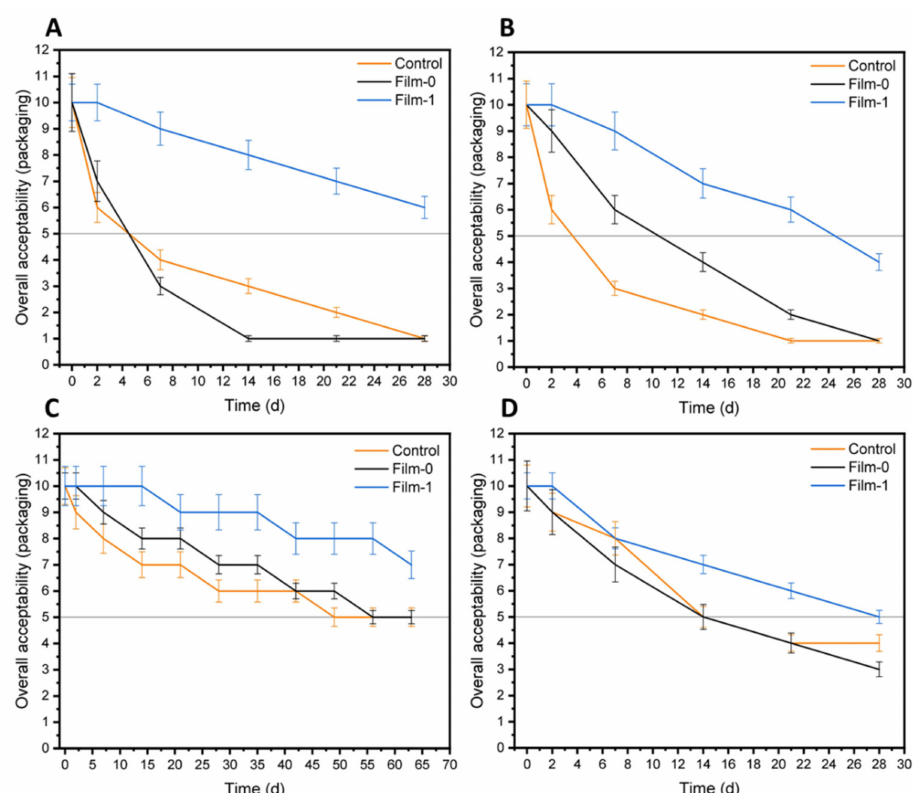
Figure 9. Evaluation of acceptance of uncoated oranges (control), BC-coated oranges (Film-0), and BC/CMC/Gly/yeast-coated oranges (Film-1) stored at ( A ) 30 ◦ C, ( B ) 40 ◦ C, ( C ) 6 ◦ C, and ( D ) room temperature (20 to 25 ◦ C for different time